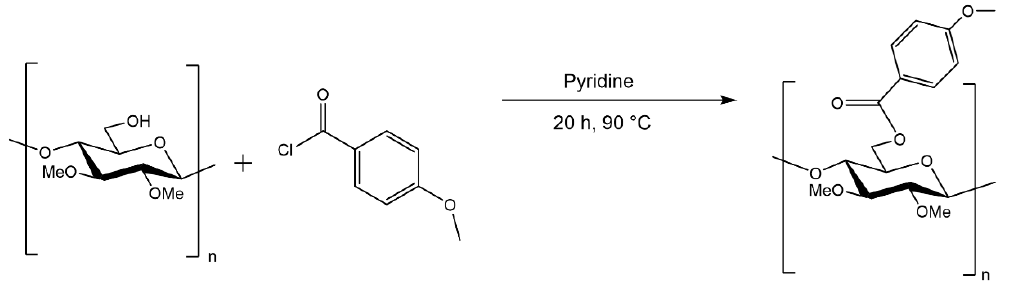
Figure 6. Transformation of MC (OMe/OH) into fully protected cellulose derivative (MC-MeOBz, OMe/OBzOMe).